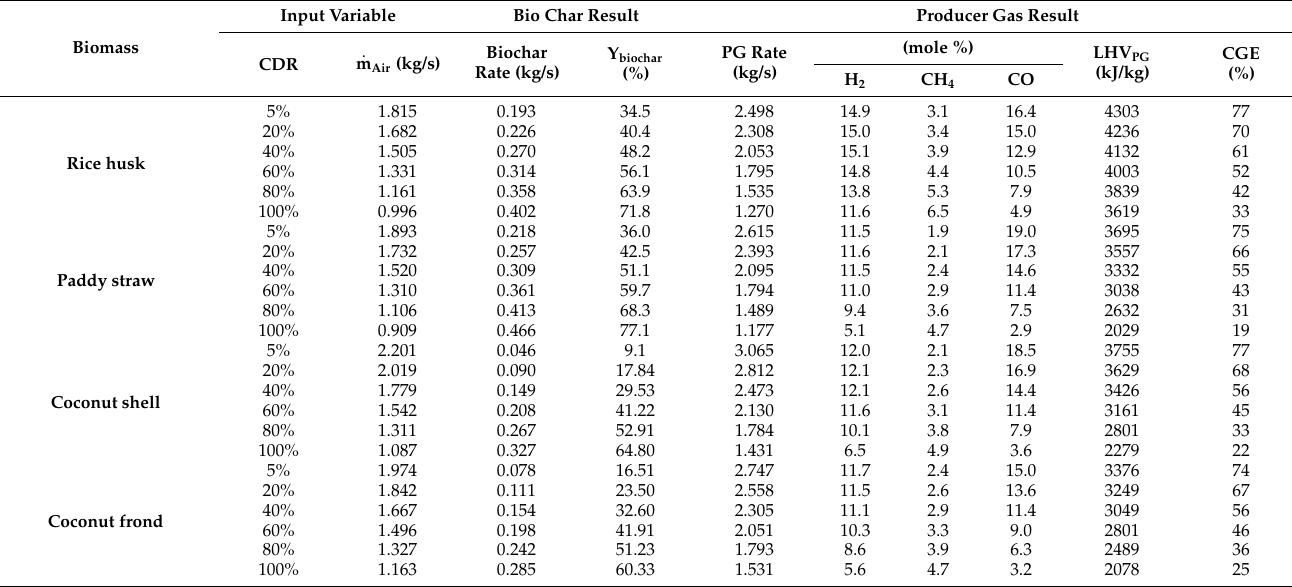
Table 4. Parametric study result for three-reactor